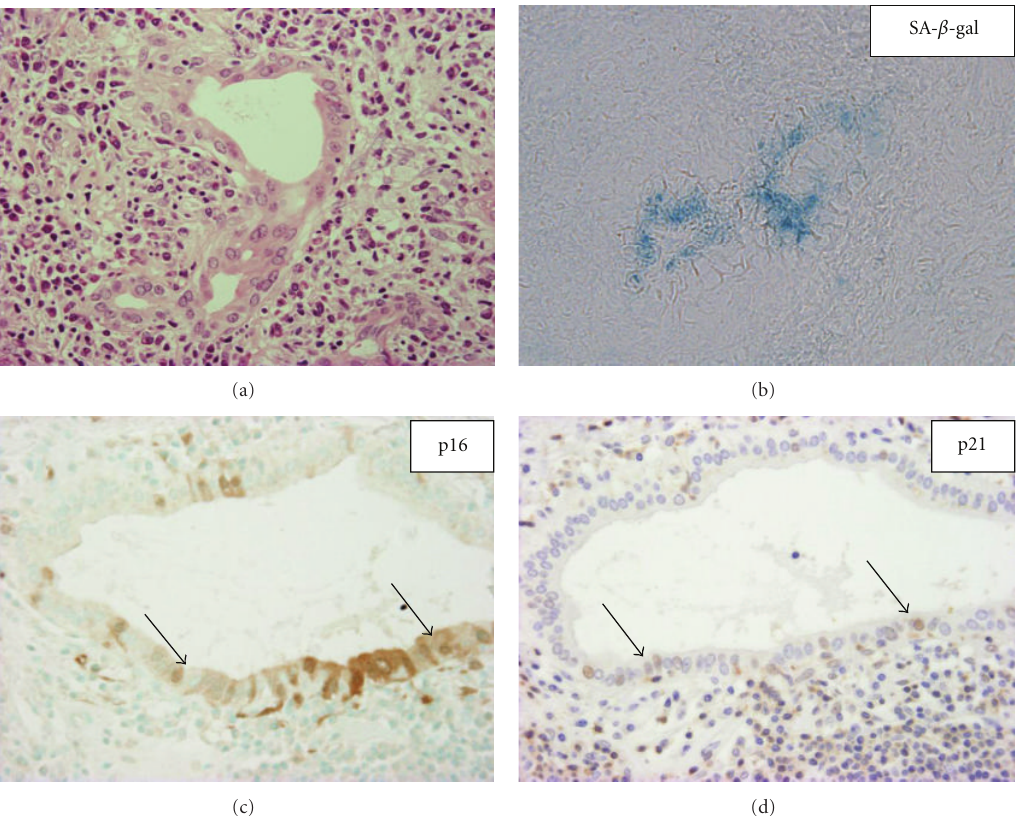
Figure 1: Biliary epithelial senescence in PBC. BECs in small bile ducts involved in chronic nonsuppurative destructive cholangitis (CNSDC) show histological features of senescence, such as cytoplasmic eosinophilia, cellular and nuclear enlargement, and uneven nuclear spacing (a). SA- β -gal activity is detected in BECs in PBC (b). Senescent markers, p21 WAF1 / Cip1 and p16 INK4a , were expressed in BECs in damaged small bile ducts in PBC (c) and (d). Immunostaining for p21 WAF1 / Cip1 and p16 INK4a . Original magnification: ×